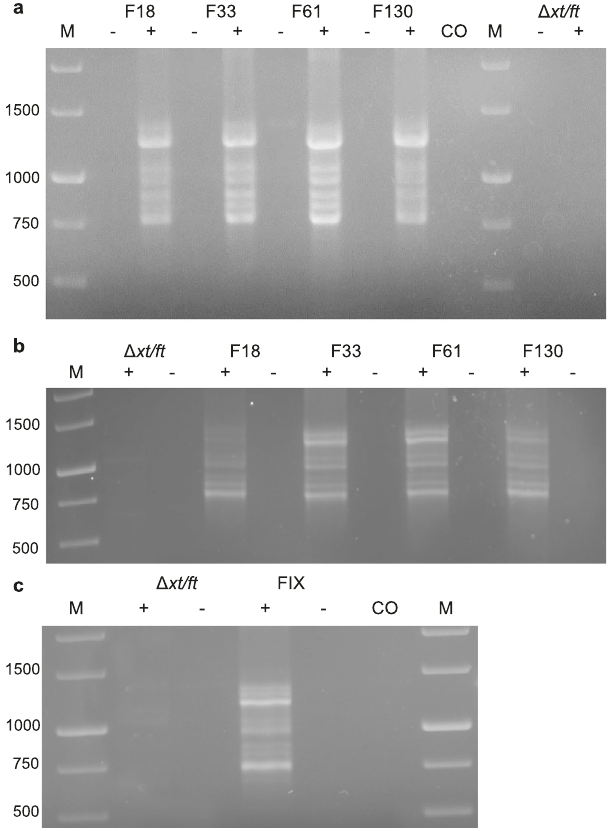
Fig. 1 Expression of FIX in Physcomitrella. a Total RNA from protonema cultures of 4 FIX-transgenic lines (F) and the parental line Δ xt/ft was prepared and used for RT-PCR using the primers FIXfwdB and FIXrevB. b RT-PCR of FIX using the primers FIXfwdB and FIXrevB from gametophores of the same lines. c RT-PCR of FIX with mRNA extracted from transiently transfected (FIX) as well as non-transfected ( Δ xt/ft ) cells. M: 1 kb Marker (Thermo Fisher Scienti fi c), -: without reverse transcription, + : with reverse transcription, CO: Water